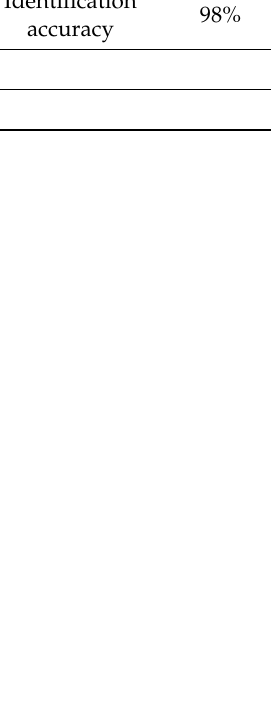
Table 4. Classification results of TDV-CNN method.